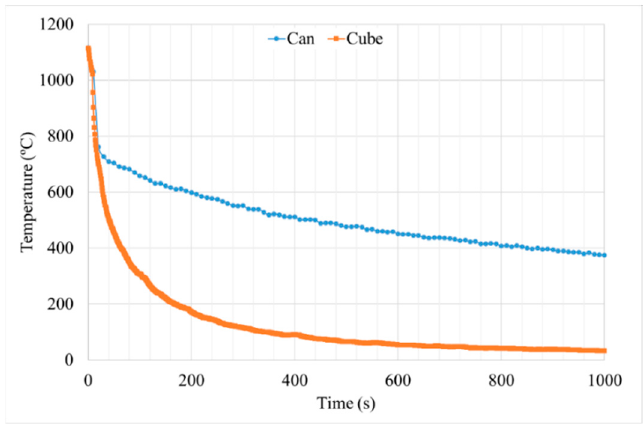
Figure 14. Temperature evolution during the solution cooling process of cube and can. From HT-A samples the average cooling rate between 1115 °C and 400 °C were calcu- lated in order to maintain the same temperatures range controlled, as in the HIPping cycle. The cube sample has a cooling rate of 11.2 °C/s, whereas the can has 0.8 °C/s, which indicates the huge difference between those samples in terms of cooling speed (see Table 4).